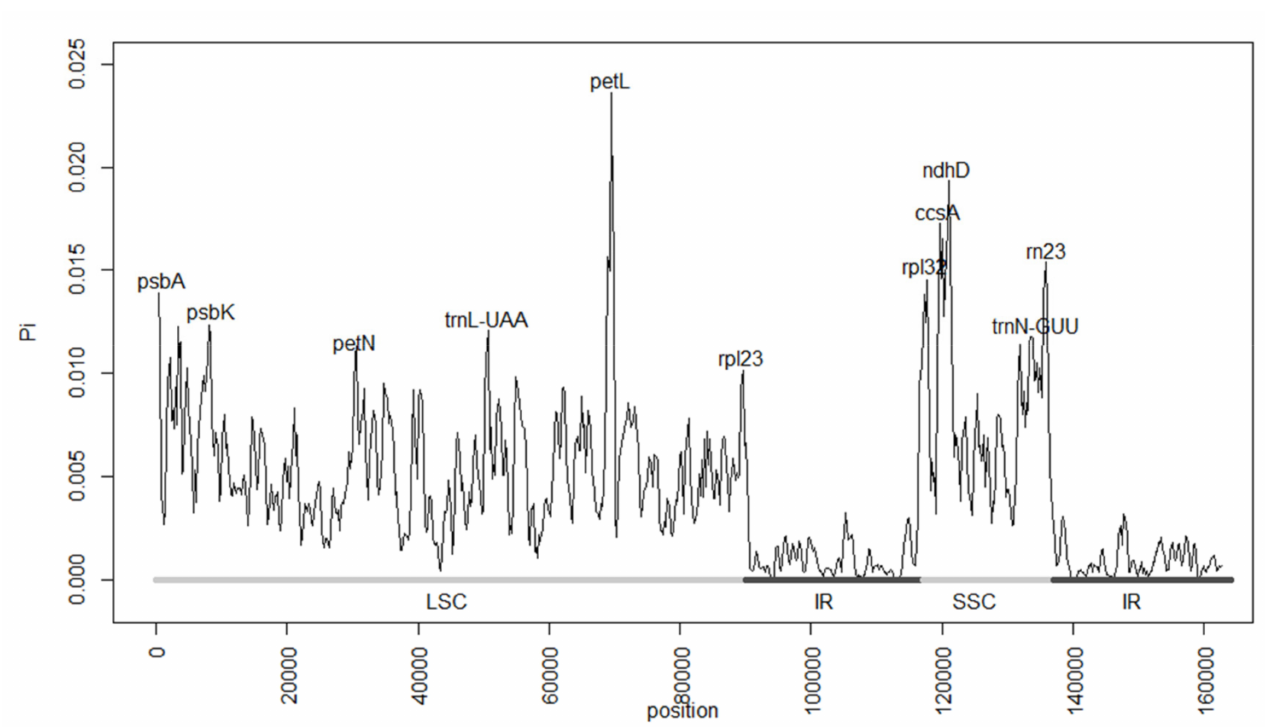
Figure 2. Nucleotide diversity (Pi) values resulting from the sliding window analysis of the 37 included Magnoliaceae plastomes. The Pi values ranged from 0 to 0.0236. The most diverse sites corresponded to genes such as PetL , ccsA , and ndhD , while the IR regions presented the lowest diversity. LSC = large single copy region; IR = inverted repeat regions; SSC = small single copy